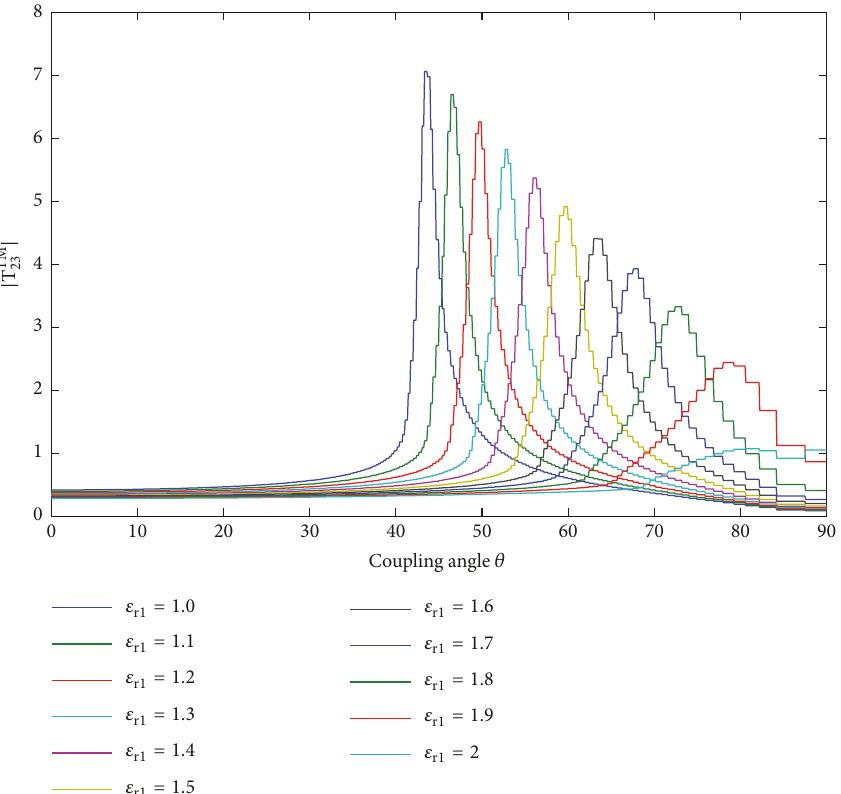
Figure 17: Generalized transmission coefficient in the gold/prism interface as a function of the coupling angle 𝜃 .